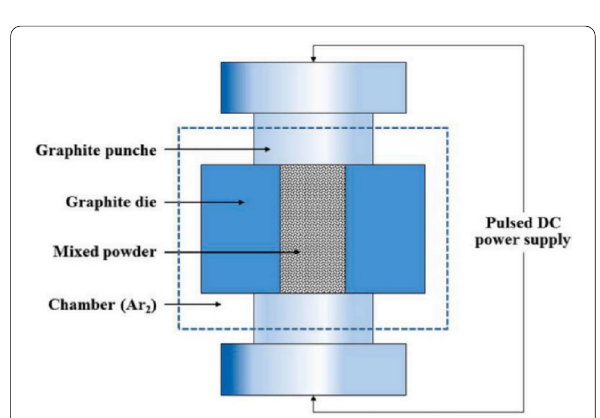
Figure 12 Schematic diagram of pressureless spark plasma